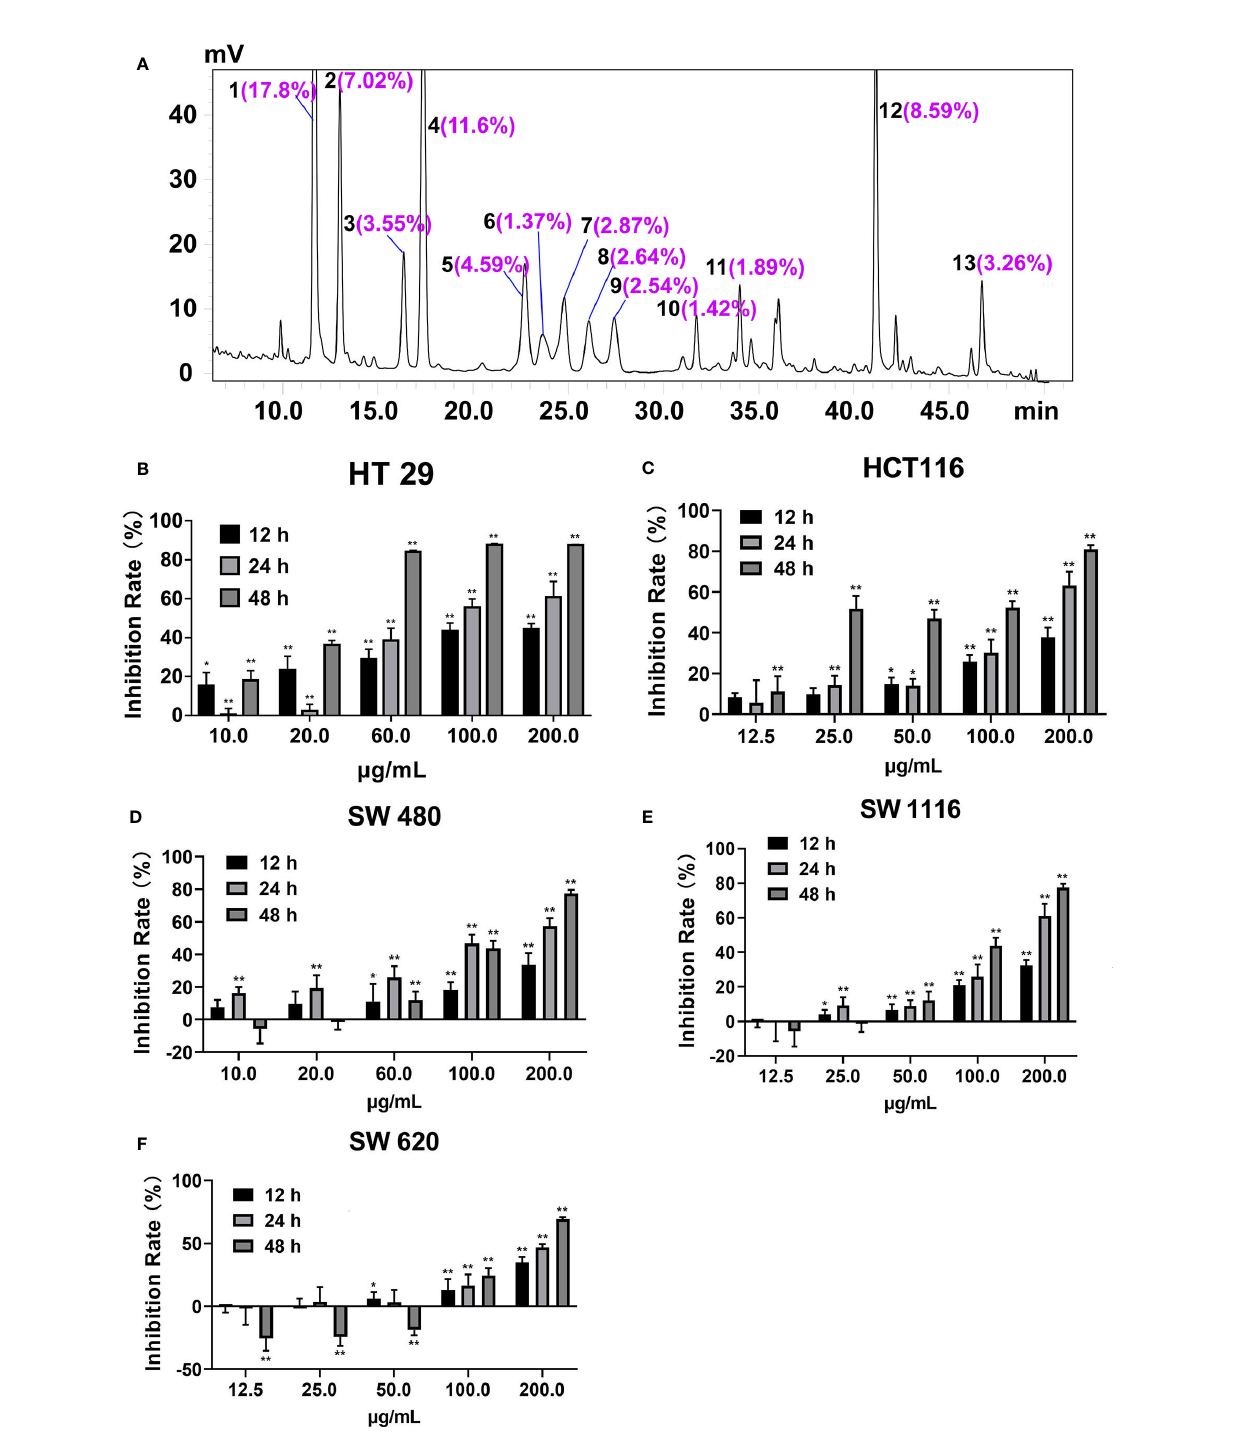
FIGURE 1 | Peak area ratios of the main components of SDEA and its effect on colon cancer cell lines. (A) Peaks 1 – 13, amento fl avone; robust fl avone; 2 ′′ ,3 ′′ - Dihydro-3 ′ , 3 ′′′ -biapigenin; 3 ′ ,3 ′′′ -binaringenin; delica fl avone; unknown; hinoki fl avone; 2,3-dihydrohinoki fl avone; chrysocaulo fl avone I; 2,3-dihydroisocryptomerin; robusta fl avone 7,4 ′ -dimethyl ether; hevea fl avone; and 7,4 ′ ,7 ′′ ,4 ′′′ -tetra-O-methyl-amento fl avone, respectively. Peak area ratios were calculated from HPLC chromatography of SDEA. (B – F) Inhibitory effect of SDEA on fi ve colon cancer cell lines, The concentration of SDEA in HCT116, SW1116 and SW620 cells was 12.5 – 200 m g/ml, while that of HT29 and SW480 cells was 10 – 200 m g/ml, n ≥ 5, * p < 0.05; ** p < 0.01, vs. control group,